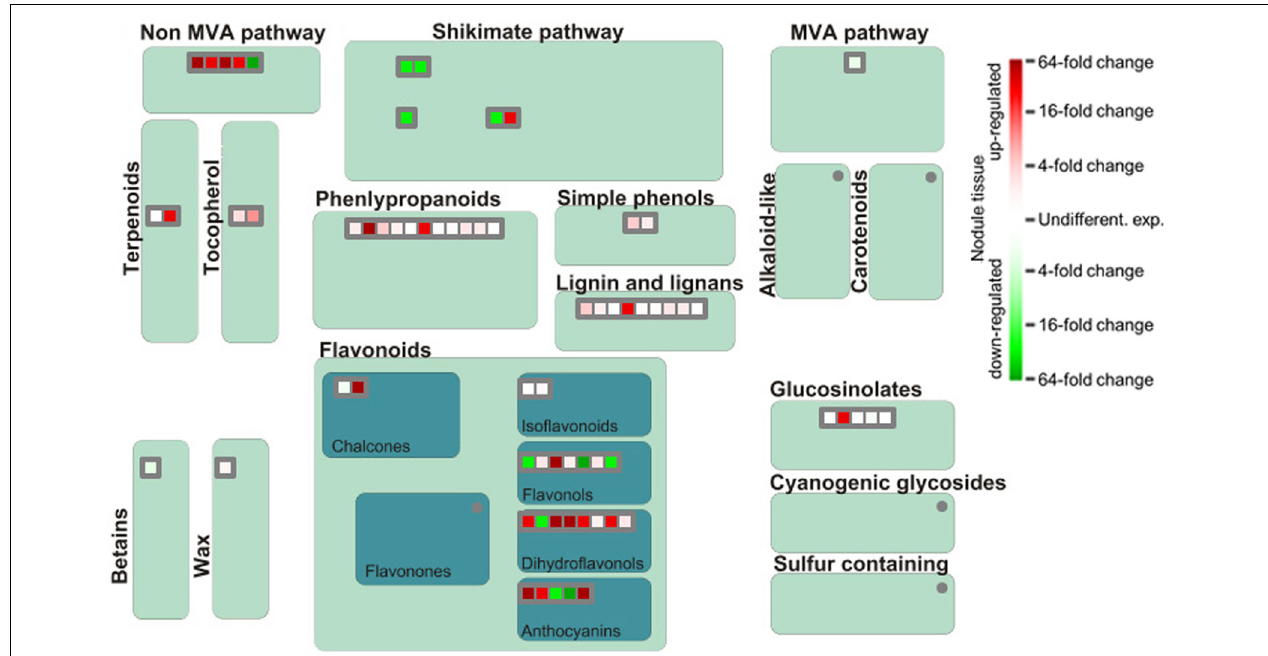
FIGURE 6 | Differential expression of genes involved in biosynthesis of secondary metabolites. Please consult Figure 4 for further details.